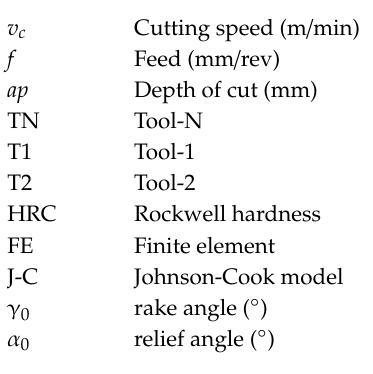
Figure 18. Interaction of the cutting parameters on surface residual stress.